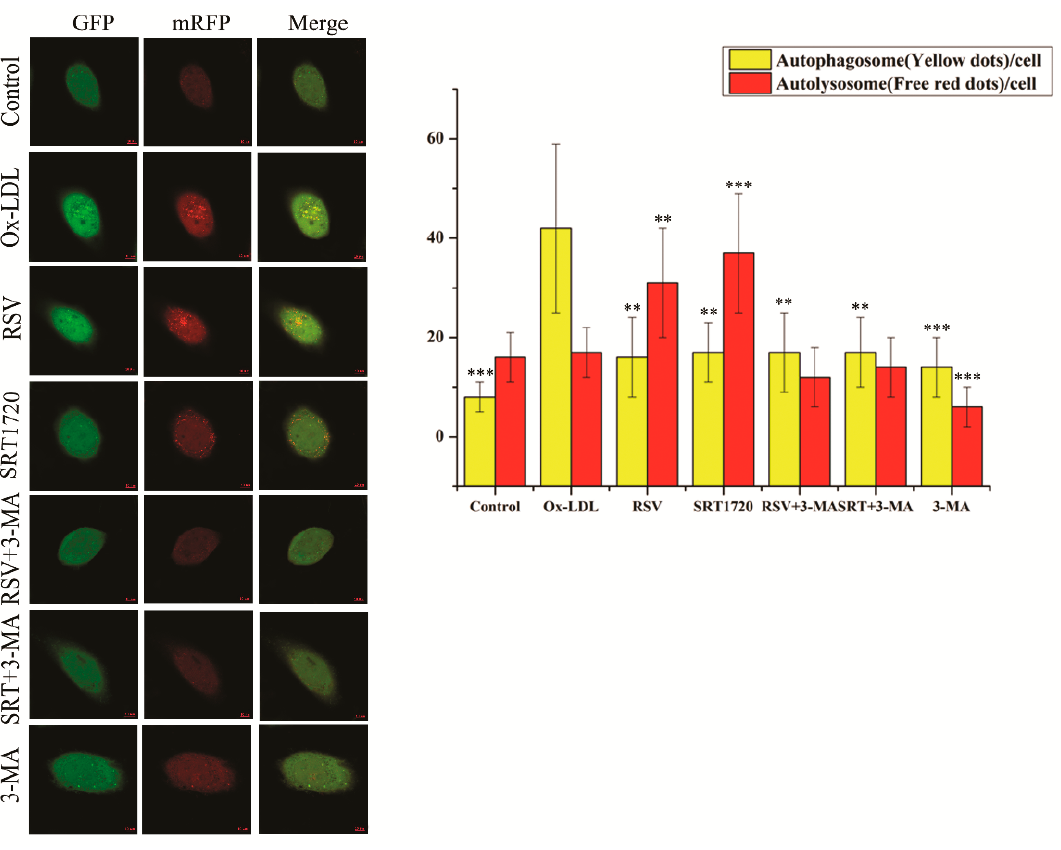
Figure 4. HUVEC were transfected with mRFP-GFP-LC3 adenoviral particles (MOI = 50) for 48 h, during which HUVEC were cultured with 100 µ g / mL ox-LDL and 10 µ M RSV or 5 µ M SRT1720 for 12 h. The formation of autophagosome (yellow fluorescence) and autolysosome (red fluorescence) was detected by confocal microscopy (Scale bar, 10 µ m, 40 × 10 magnification). Values are presented as the means ± SD ( n = 15). Compared with the ox-LDL group, ** p < 0.01, *** p < 0.001.